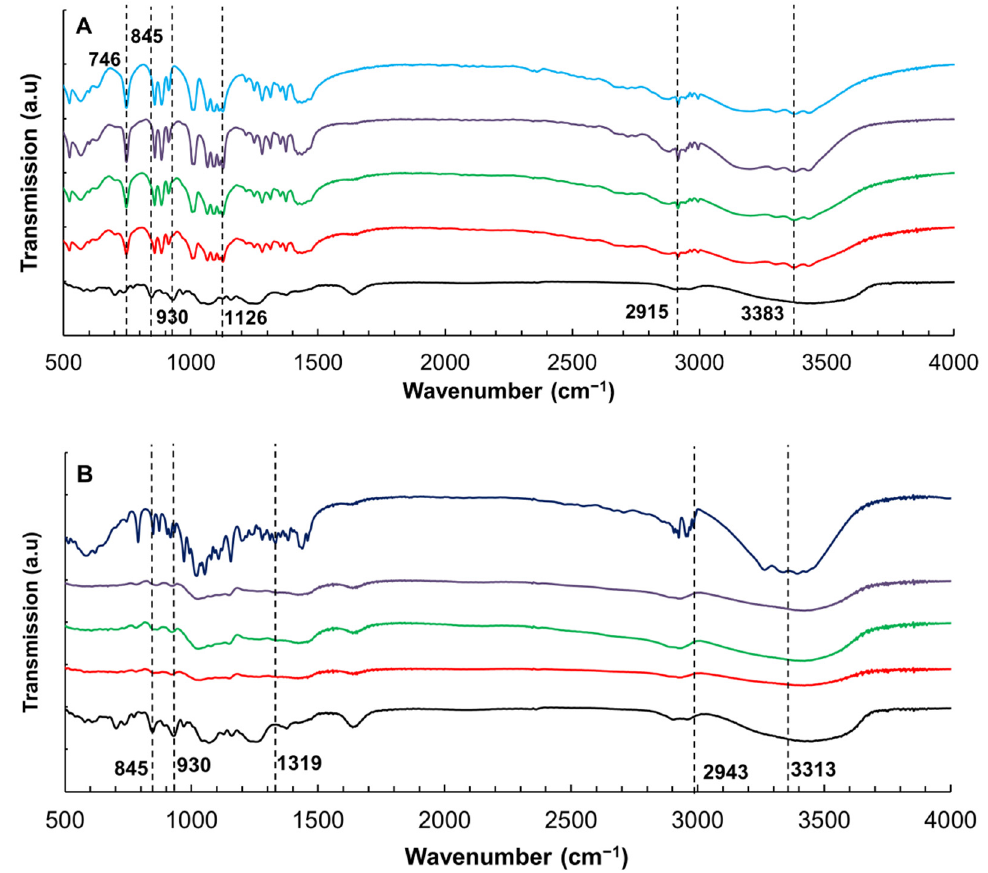
Figure 3. FTIR spectrum of κ -carrageenan ( κ -C) with addition of xylitol ( A ) and maltitol ( B ). Pure xylitol and maltitol is also included as a reference. Black line: pure κ -C; red line: 10 wt% addition; green line: 20 wt% addition; purple line: 30 wt% addition; teal line: xylitol; blue line: maltitol.